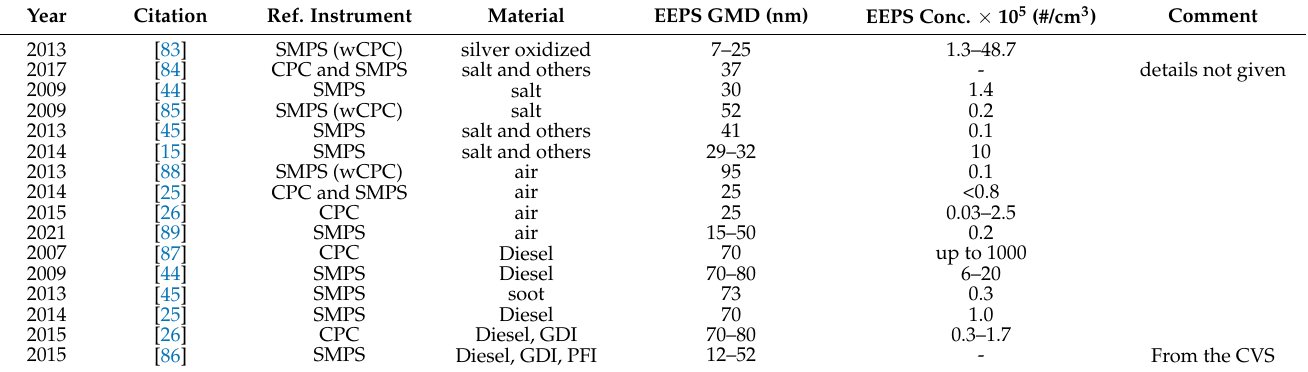
Table A1. Overview of studies that compared EEPS with SMPS or CPC. SMPS with butanol CPC unless stated otherwise: water CPC